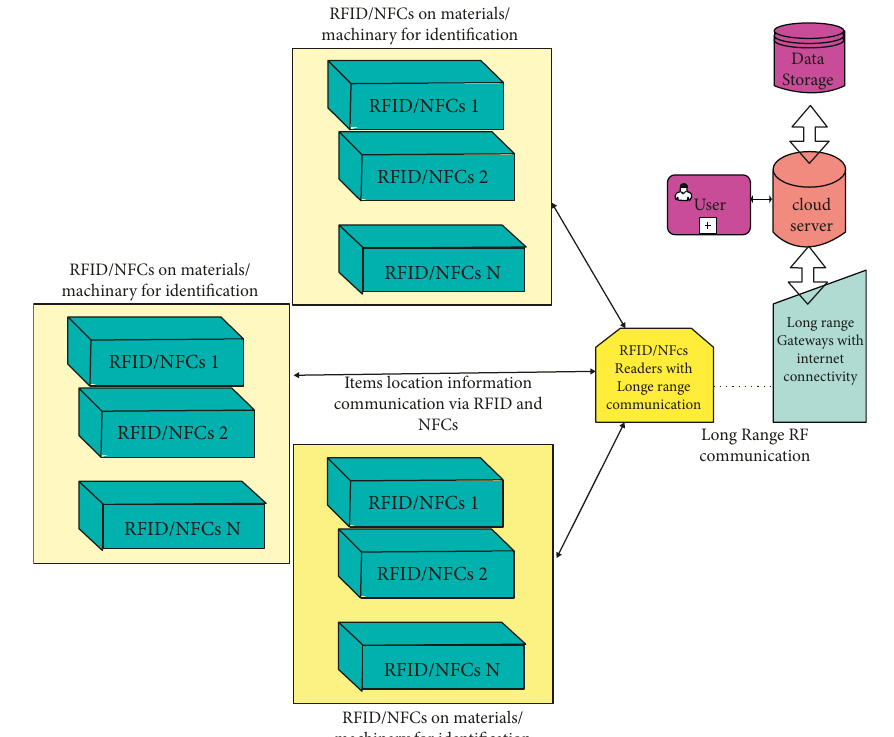
Figure 12: IoT and RFID in the construction industry.